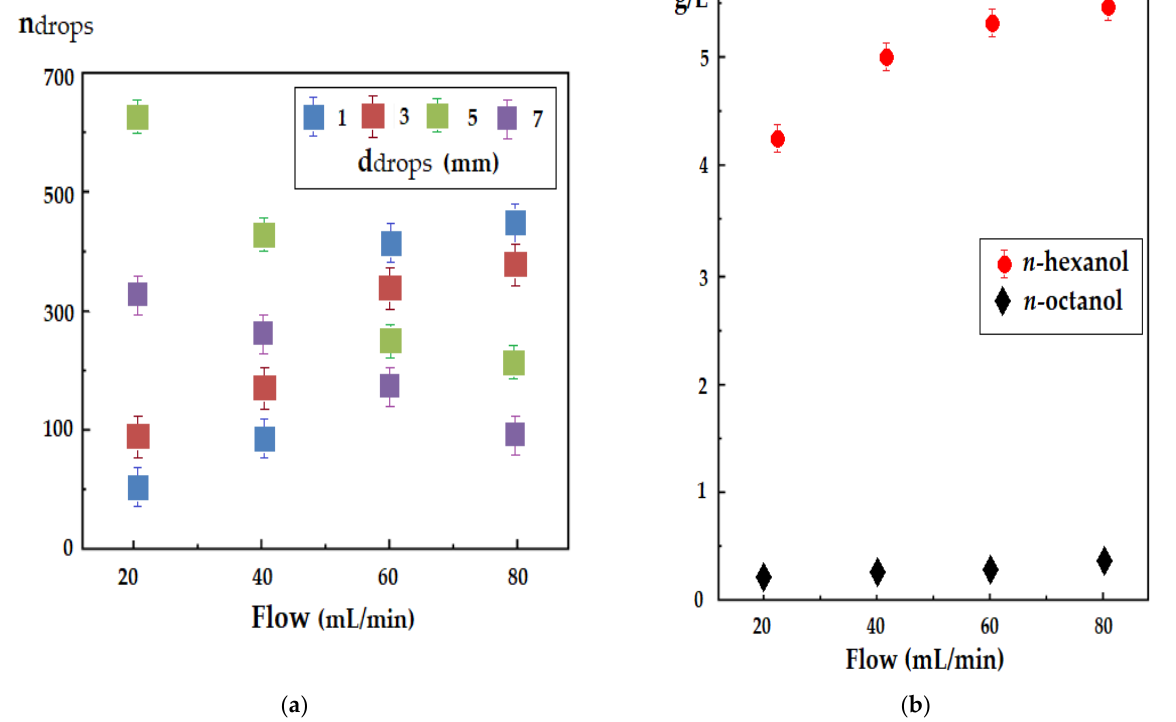
Figure 5. Droplet size depending on flow rate ( a ) and loss of membrane material in the source phase depending on the flow rate for n -hexanol and n -octanol ( b ).